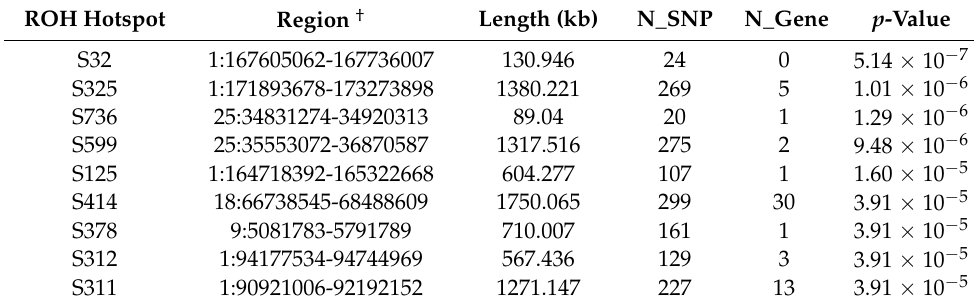
Table 4. Nine ROH hotspots significantly linked to litter size in Hu sheep.